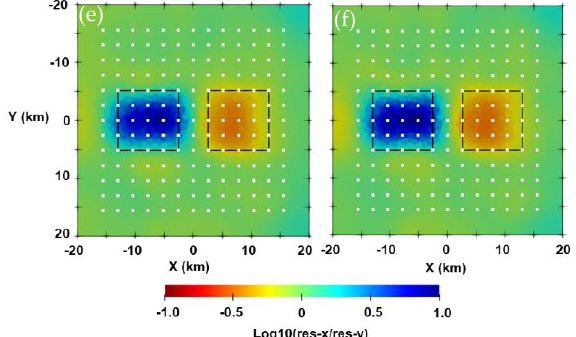
Figure 16. Anisotropic inversion results at z = 6 km. Panels ( a ) and ( b ) show the inverted resistivity in the principal X direction when including and excluding the vertical resistivity in the inversion. Panels ( c ) and ( d ) show the inverted resistivity in the principal Y direction when including and excluding the vertical resistivity in the inversion. Panels ( e ) and ( f ) show the inverted anisotropic coefficient when including and excluding the vertical resistivity in the inversion.